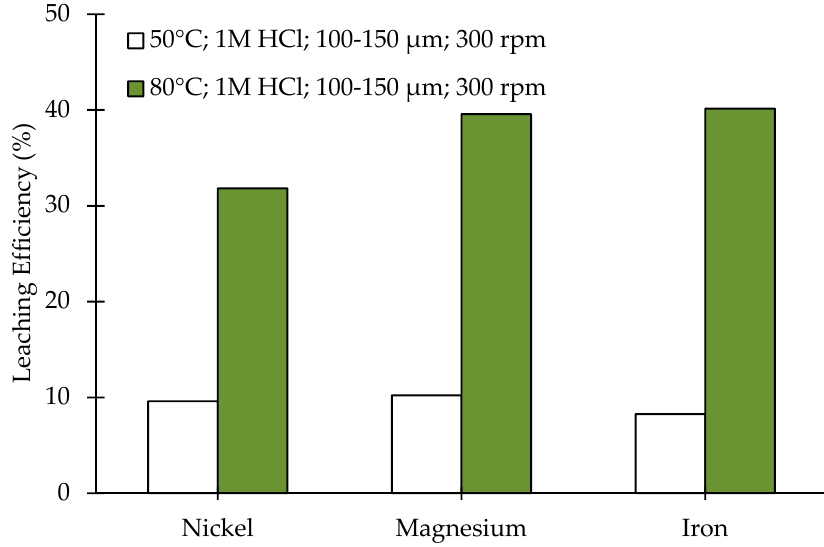
Figure 9. Leaching efficiency depending on a leaching temperature, 100–150 µm, 90 min, 1 M HCl and 300 rpm.